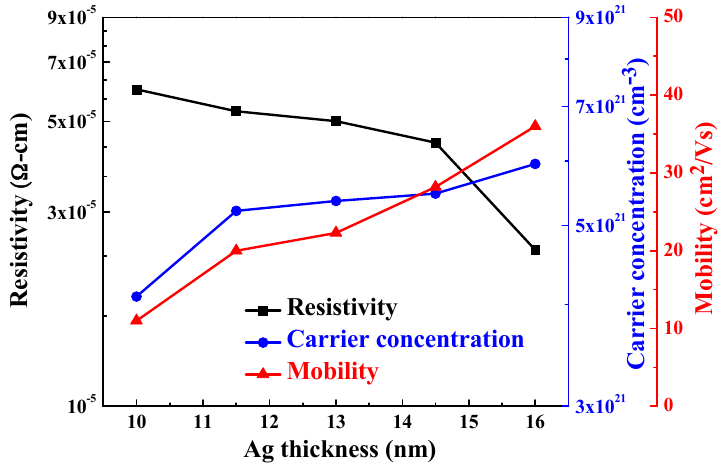
Figure 3. Hall measurement of the α -IGZO/Ag/ α -IGZO triple-layer structure as a function of thickness of Ag film, where thickness was changed from 10 nm to 16 nm.